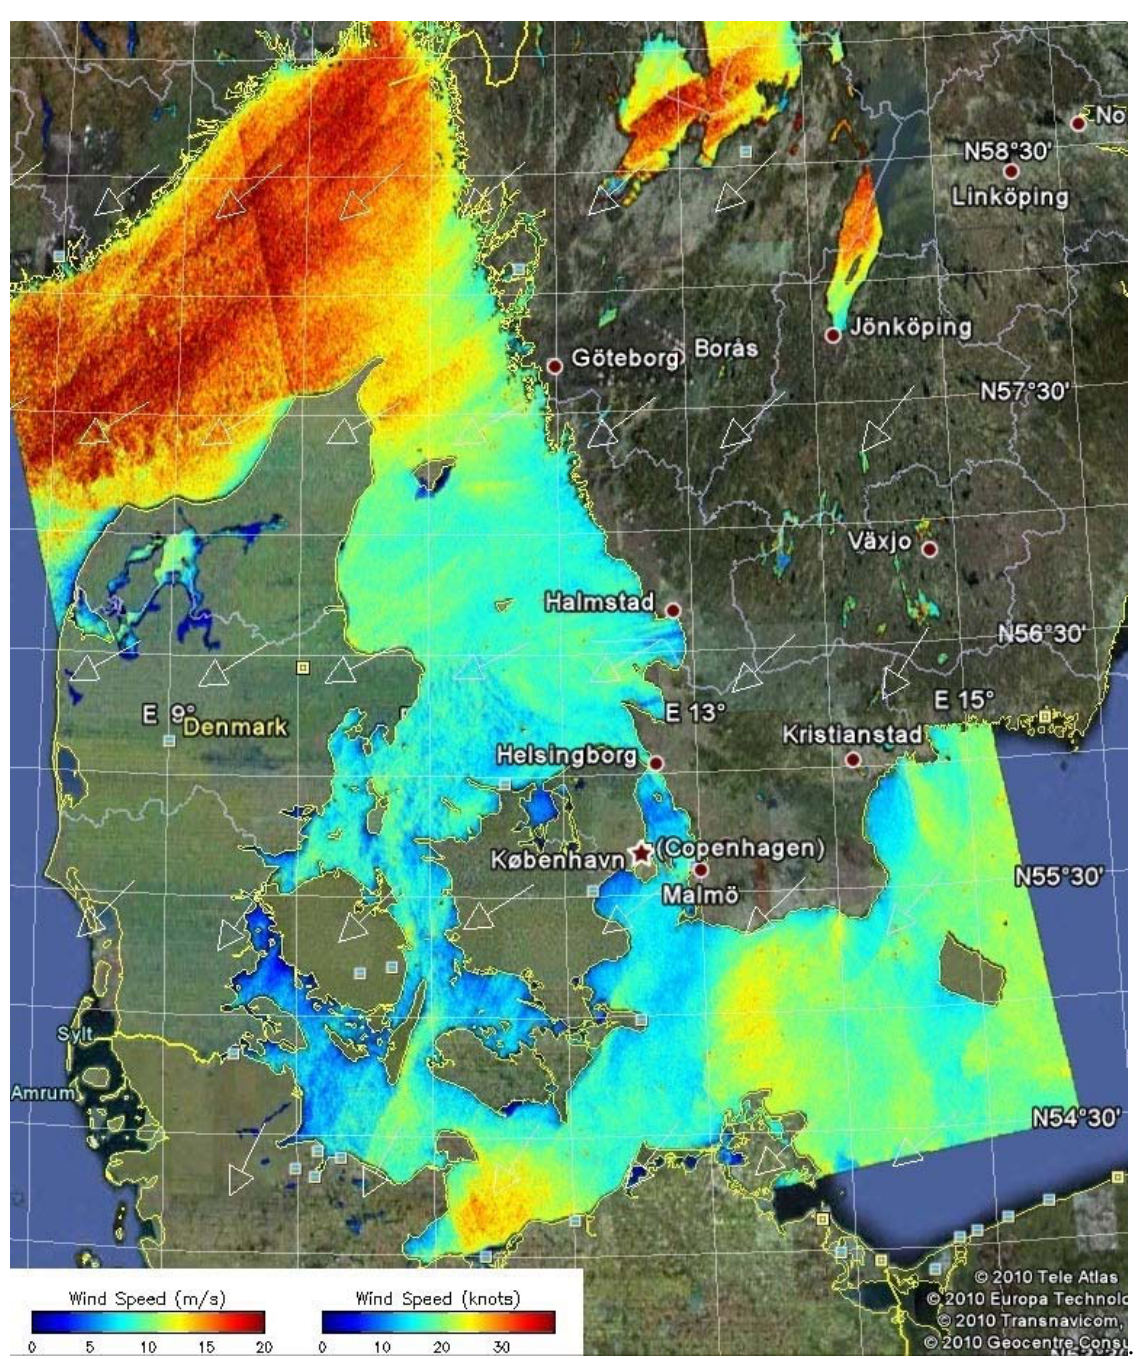
Figure 2. Wind speed map of the South Baltic Sea and interior Danish Seas observed from Envisat ASAR wide swath mode on 1 January 2010 at 20.48 UTC with the NOGAPS wind direction vectors shown in white. Risø DTU/JHU